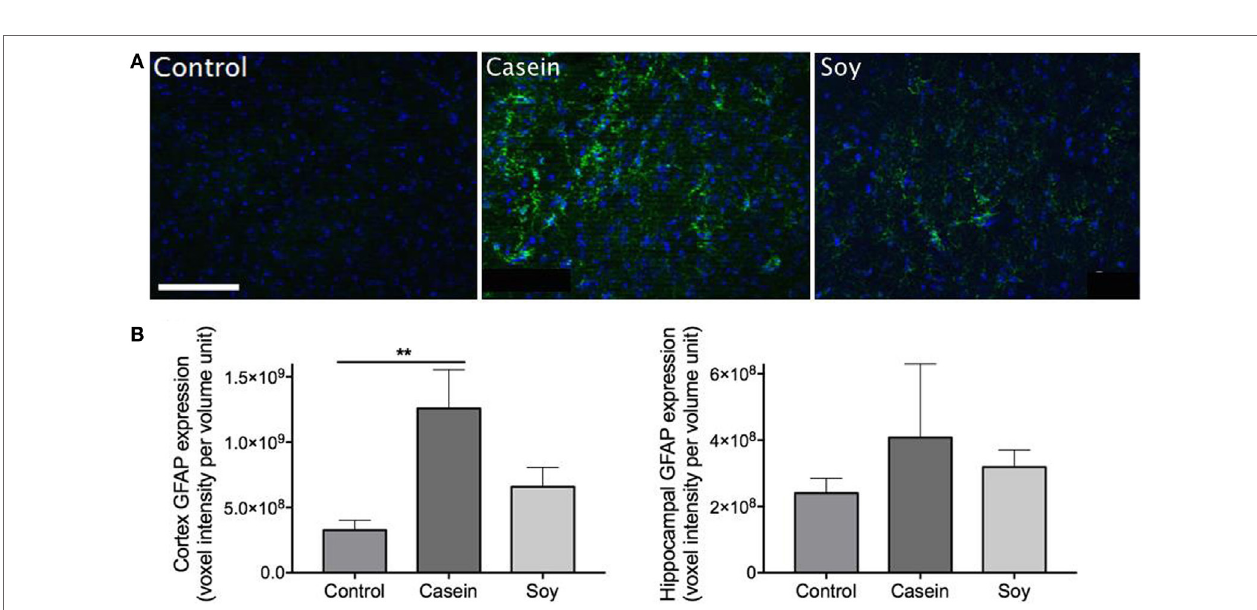
FigUre 2 | Semiquantitative analyses of cerebral glial fibrillary acidic protein (GFAP) expression. Neuroinflammation was assessed via immunofluorescent detection of GFAP expression within the cerebral parenchyma of mice maintained on control chow, high-casein diet, or high-soy protein diet. (a) The micrographs show representative immunofluorescent staining of GFAP (green) with DAPI counterstaining (blue) in the cortex. Scale bar = 100 µm. (B) Semiquantitative analysis of GFAP extravasation in cerebral cortex and hippocampal formation are shown. The statistical significance is indicated with ** at p < 0.01 (Mann–Whitney test, n = 10). Data shown as mean ± SEM.